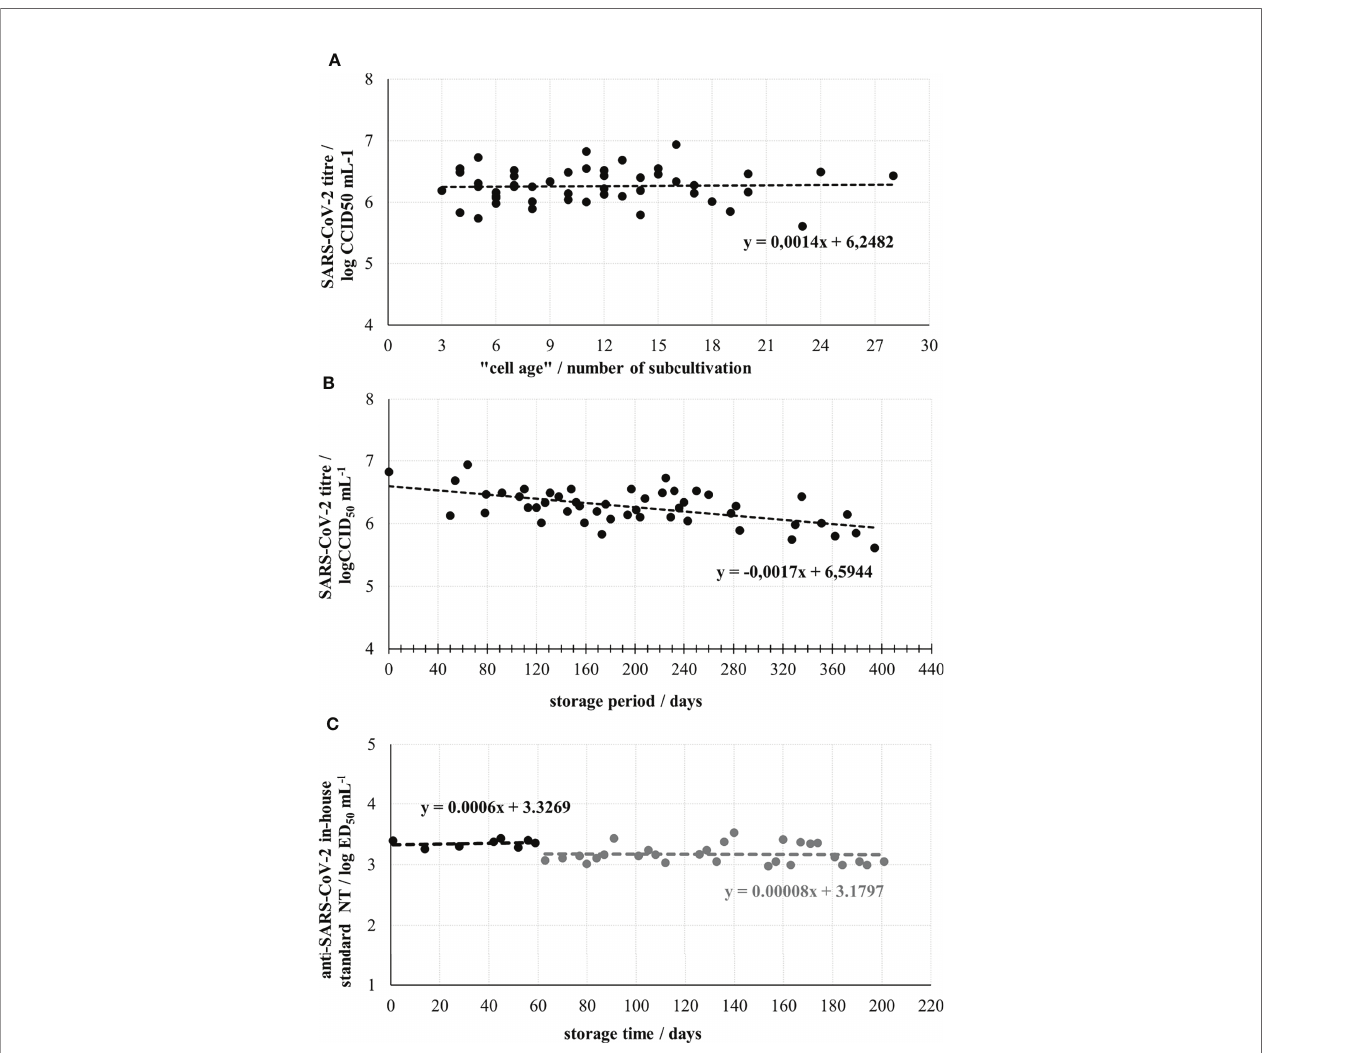
FIGURE 1 | Optimization and control parameters of the neutralisation assay performance. (A) SARS-CoV-2 working stock titre determined in assay runs using Vero E6 cells from different subcultivations. (B) SARS-CoV-2 working stock stability during the storage at -60°C or below. (C) Stability of anti-SARS-CoV-2 in-house standard during 6-month storage. The break in line indicates the start of two times lower dilution of SARS-CoV-2 working stock usage as a challenge virus, due to the drop of its